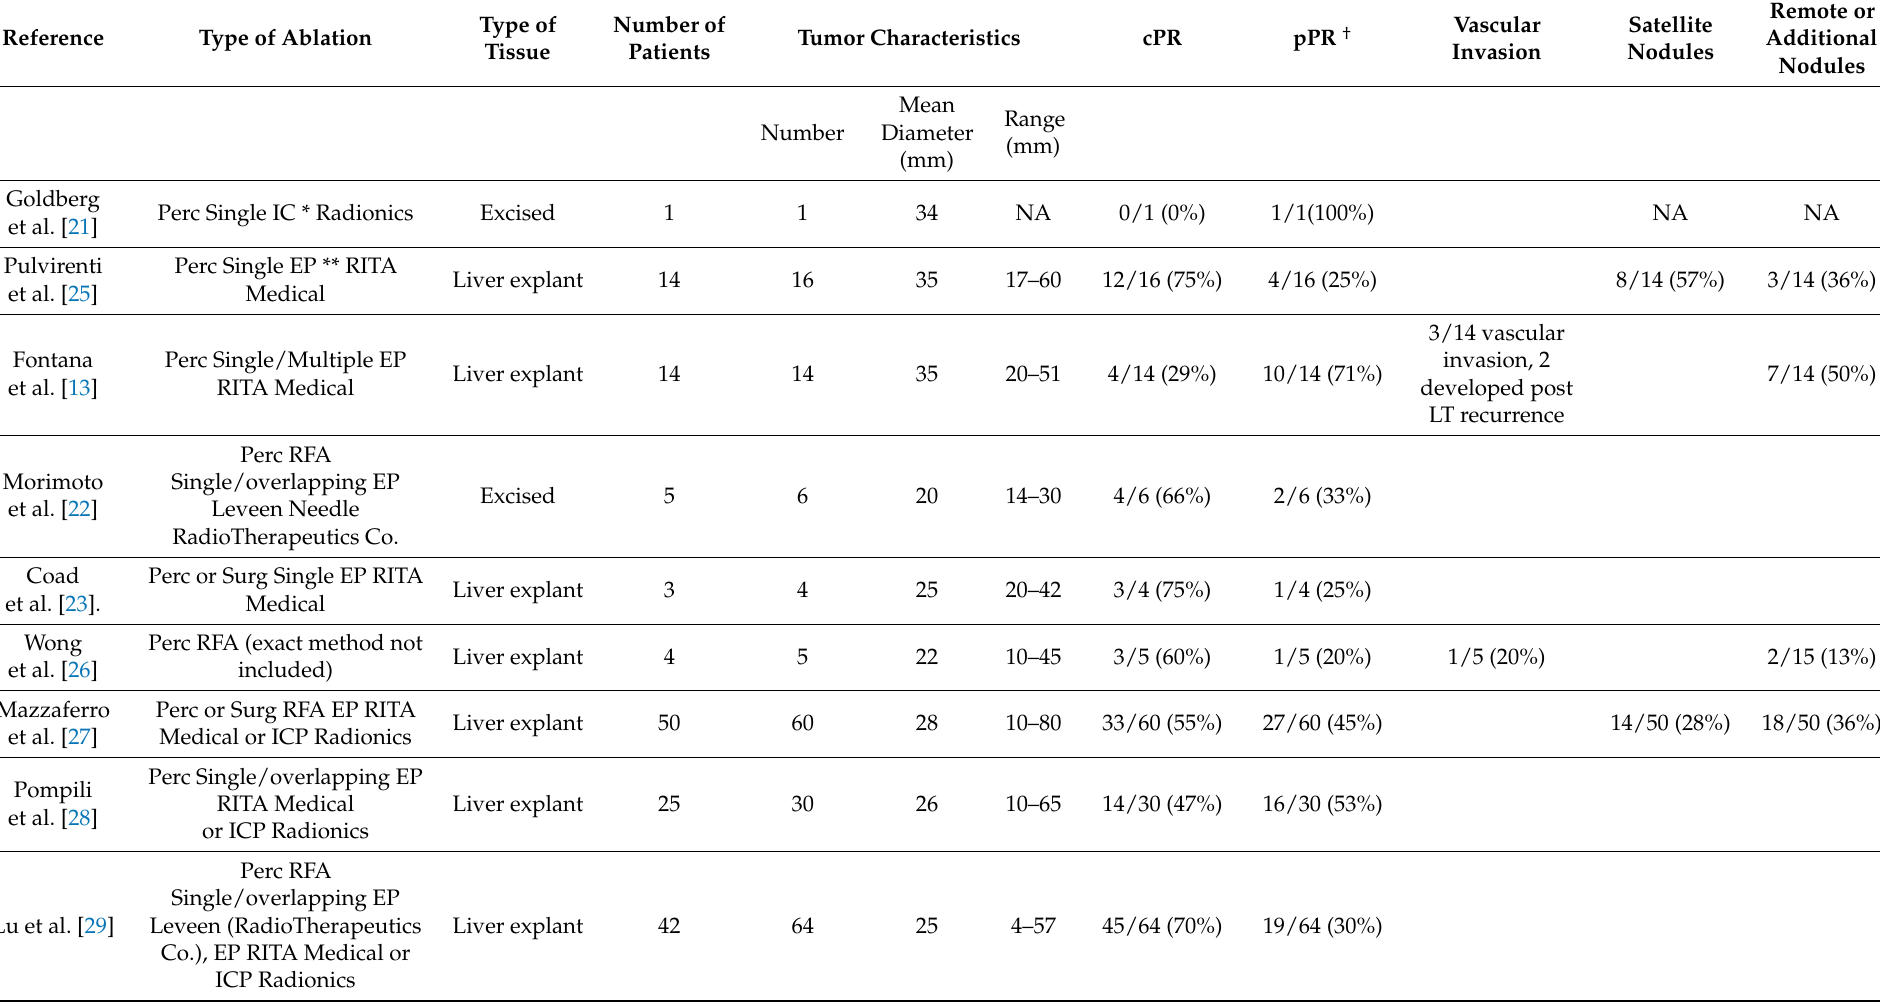
Table 1. Comparison of the rate of complete response following radiofrequency ablation (RFA) for the local control of hepatocellular carcinoma (HCC) based on histopathological evaluation of the excised tumors or liver explants at the time of